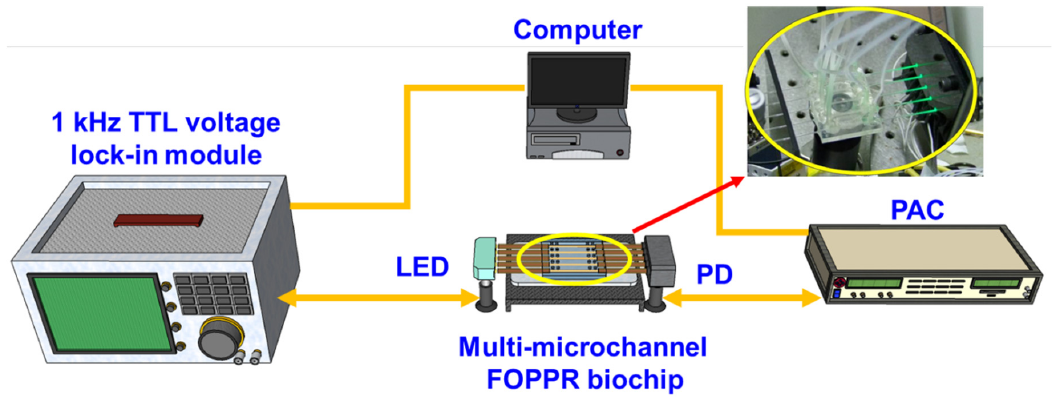
Figure 2. Schematic representation of the experimental setup of the multi-microchannel sensing system (Inset: The image of multi-microchannel FOPPR biochip). TTL: transistor-transistor logic; LED: light-emitting diodes; PD: photodiode; PAC: photoreceiver amplification circuit.